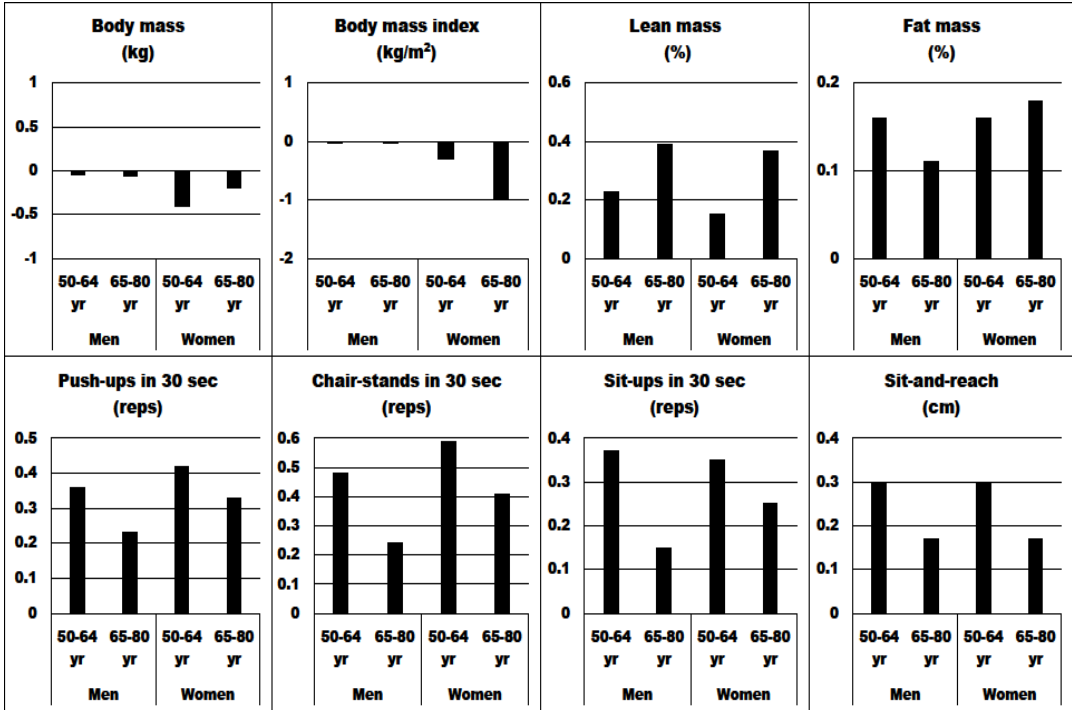
Figure 2. Effect sizes for body composition, muscular fitness and flexibility before and after the 4- week resistance training across the age groups in years (yr).